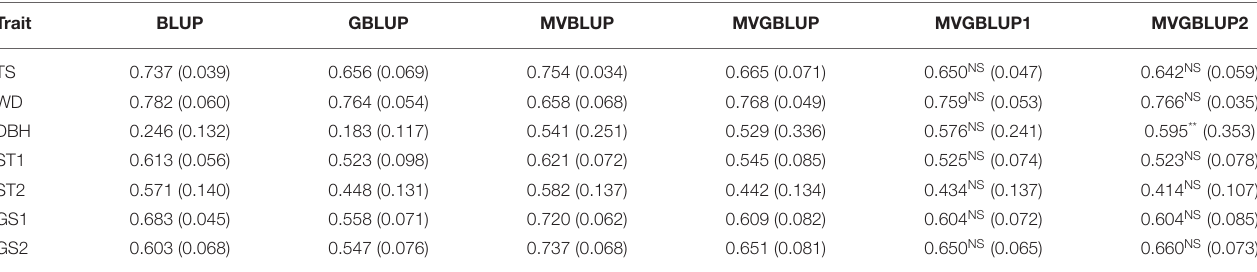
TABLE 3 | Prediction accuracies and their standard deviations (in parenthesis) obtained from multivariate mixed models in the E. nitens population when using, a relationship matrix derived from sib-ship reconstruction (MVBLUP), a marker-based relationship matrix using all markers (MVGBLUP), a marker-based relationship matrix using selected SNPs having only positive loadings (MVGBLUP1), or a marker-based relationship matrix using selected SNPs having both positive and negative loadings (MVGBLUP2).